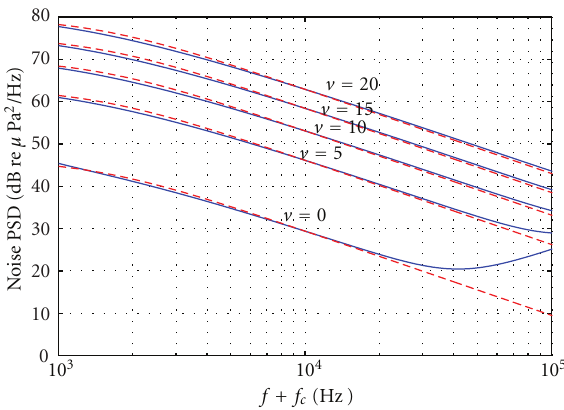
Figure 6: Power spectral density of the ambient noise for various wind speeds v , s is set to 0.5. The solid lines show the model (A.2) and dashed lines the one of (A.4). f c is the carrier frequency corresponding the 0th